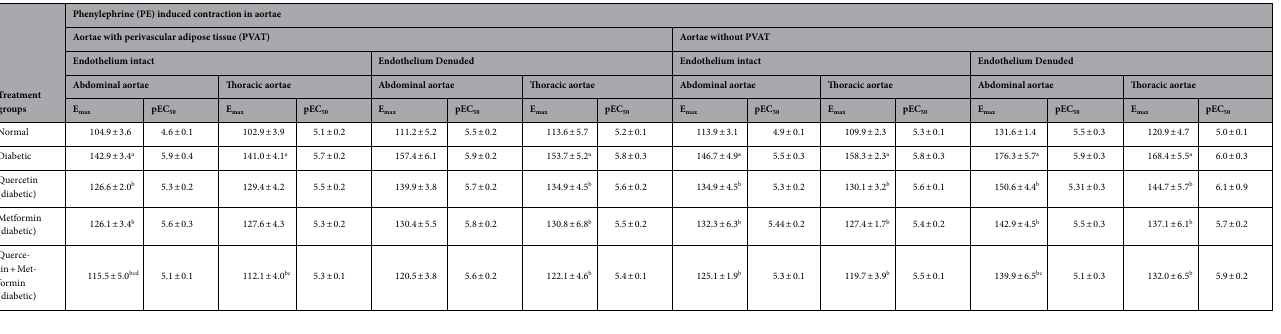
Table 1. Effect of test compounds on phenylephrine (PE) induced contraction in aortae. Data represent mean ± SEM. The alphabet, ‘a’ shows a significant difference in comparison with normal control ( p < 0.05). The alphabet, ‘b’ shows a significant difference in comparison to diabetic control ( p < 0.05). The alphabet, ‘c’ shows a significant difference in comparison with a quercetin treatment group ( p < 0.05). The alphabet, ‘d’ shows a significant difference in comparison with the metformin treatment group ( p <